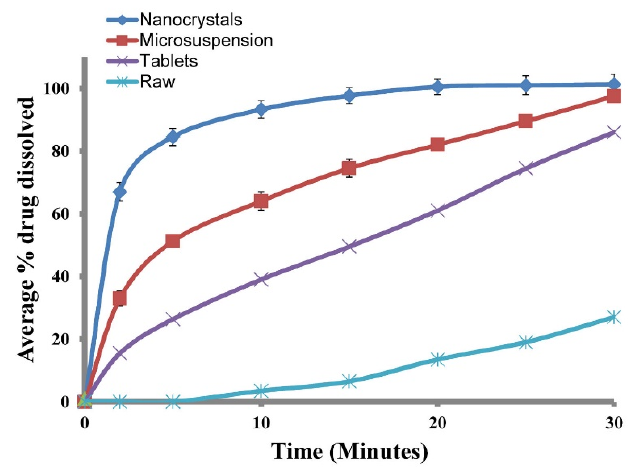
Figure 6. In-vitro dissolution studies of the repaglinide. Figure 6. In ‐ vitro dissolution studies of the repaglinide.